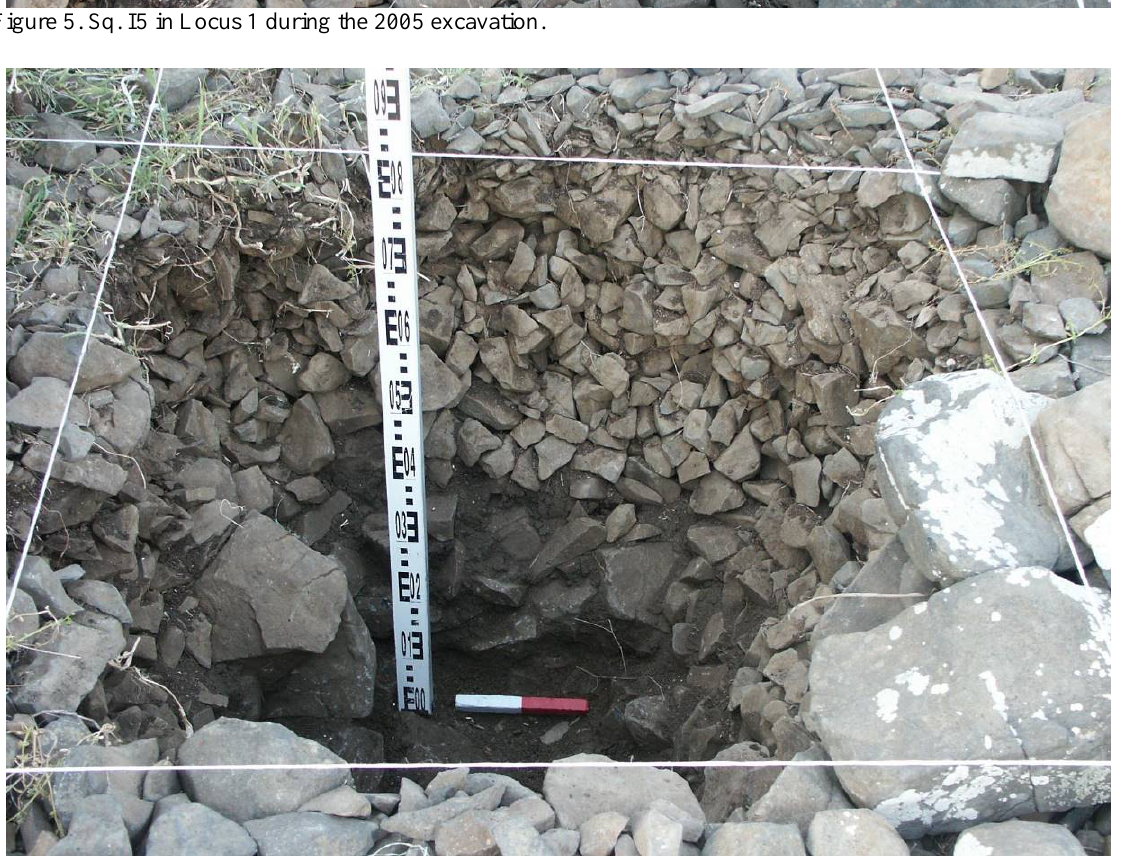
Figure 6. Square I5 showing the lower part packed with